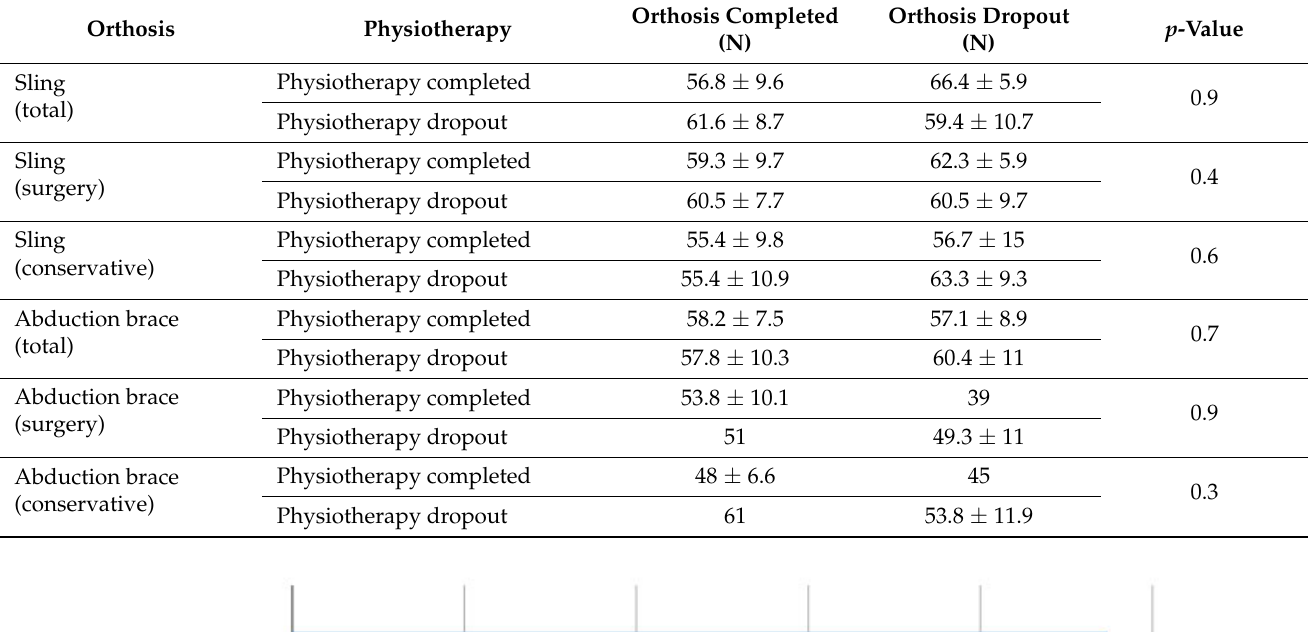
Table 3. Distribution of the CS according to compliance collectives.